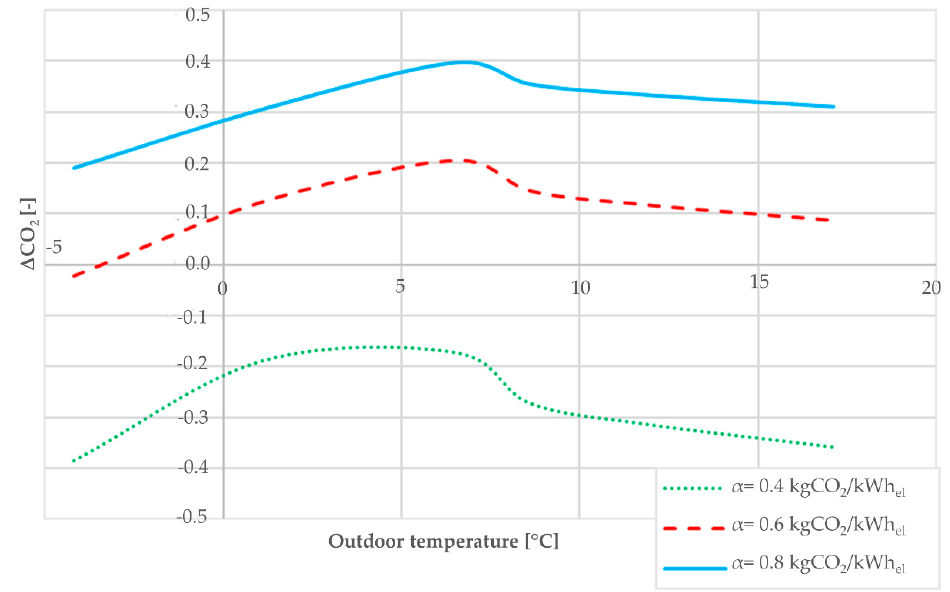
∆ CO Figure 24. Δ CO 2 as a function of outdoor air temperature and CO 2 emission factor. Figure 24. 2 as a function of outdoor air temperature and CO 2 emission factor.